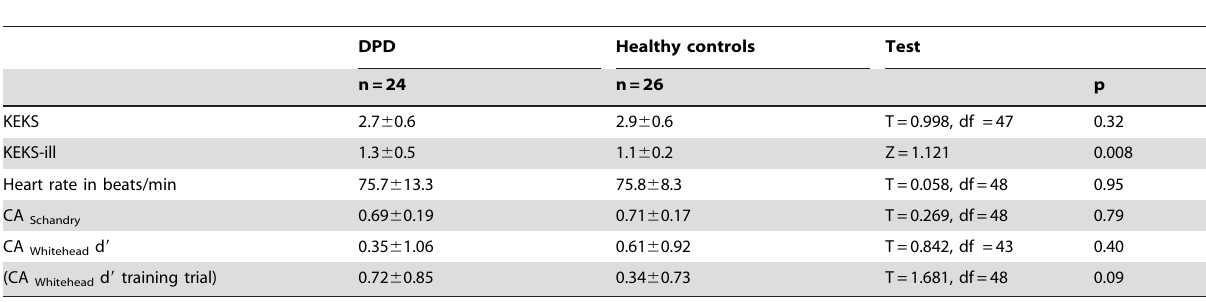
Table 3. Body perception, heart rate, and performance of heartbeat detection.